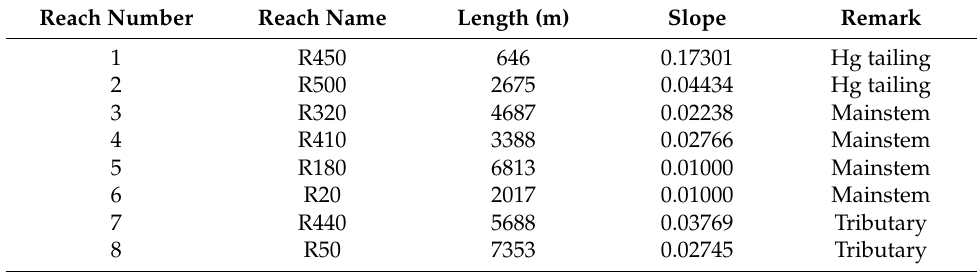
Table 4. Geometry of the Xiaxi River reaches and major tributaries.